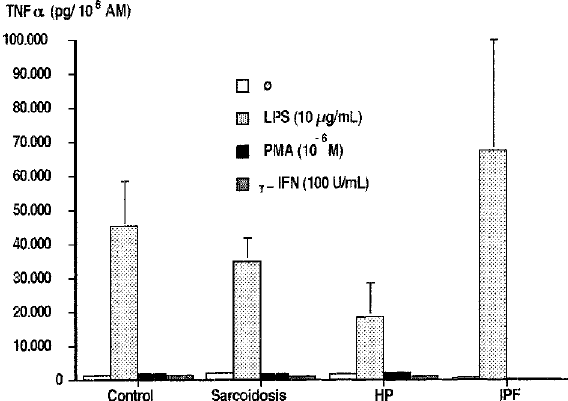
FIG. 3. Tumour necrosis factor- a secretion in the different experimental groups. Study of the effect of different stimuli on TNF- a secretion by AMs revealed statistically significant differences (Wilcoxon test, P <0.001 for LPS and P =0.002 for PMA). No significant differences were found between basal and interferon-induced secretion. Comparison of LPS- induced and PMA-induced secretion revealed statistically significant differences (Wilcoxon test, P =0.001). Comparison among the different groups study did not disclose significant differences under either basal or stimulated conditions.